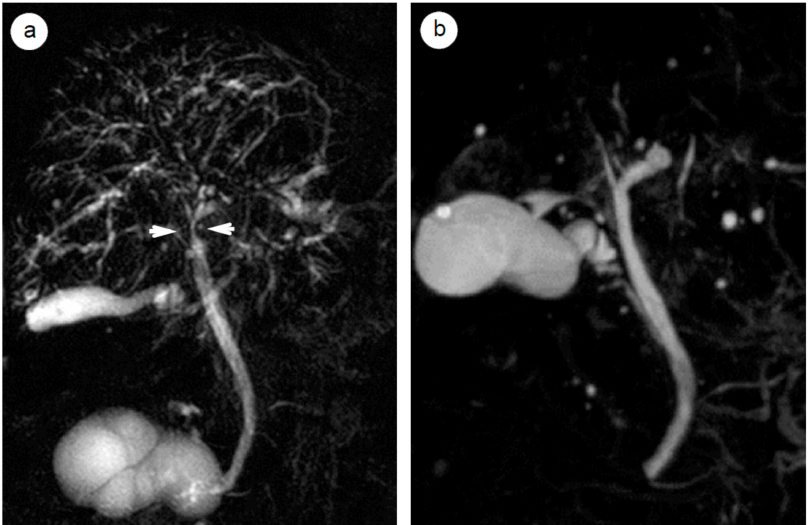
Figure 3. A case of focal-type AIP with sclerosing cholangitis at the hilar and intrahepatic bile ducts in a male 70 year-old patient. Magnetic resonance cholangiopancreatography before steroid treatment showed ( a ) multiple biliary stenosis at the hepatic hilum (arrow heads) and intrahepatic bile ducts, with improvements 3 months after steroid therapy ( b